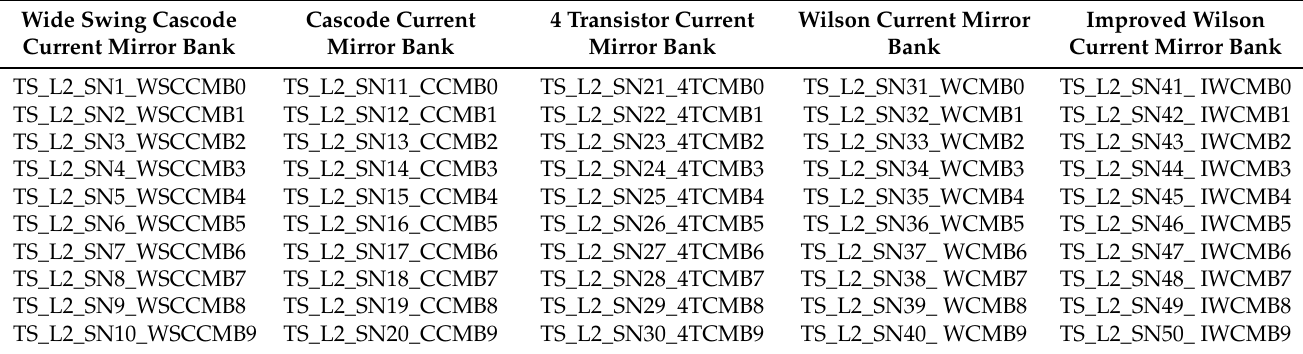
Table 2. Created dataset in Cadence Virtuoso: For each class of current mirror banks, 10 schematics were created by adding more banks. The first sample was created with no banks at all, and the last one was created with nine banks.